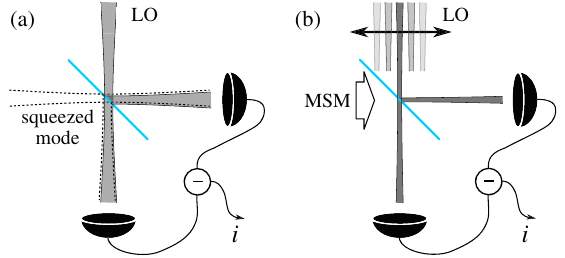
FIG. 1. The homodyne detection of a squeezed state leads to reduced noise on the balanced photocurrent i below the QNL. (a) For a single-spatial-mode squeezed state, the mode of the LO must match the squeezed mode. (b) For a hypothetical MSM squeezed state, the LO could have any shape or